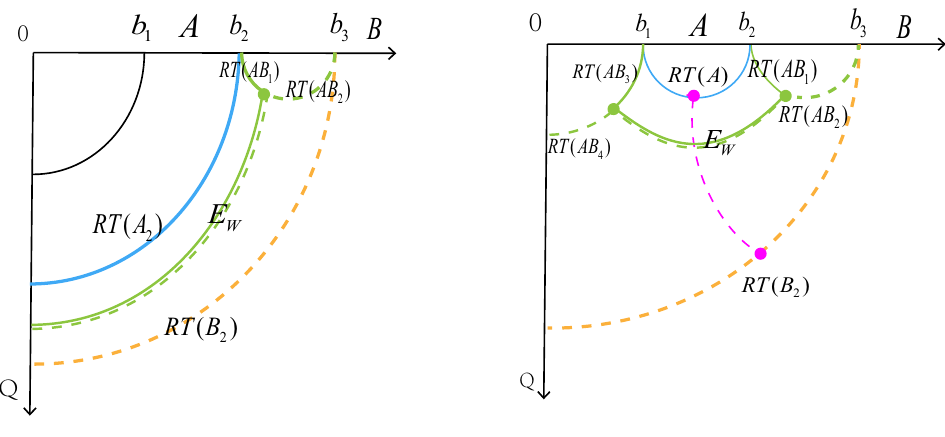
log 2 for phase-D4. Right: 3 log 2 for 3